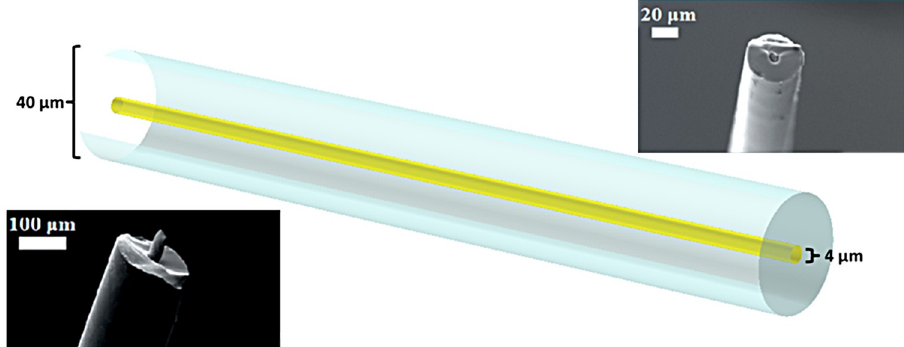
Figure 2. Schematic of a 4 μm gold core/40 μm borosilicate glass cladding fiber. The insets present characteristic SEM images of actual microwires of different diameters. Adapted with permission from [6]. Copyright 2018 American Chemical Society.